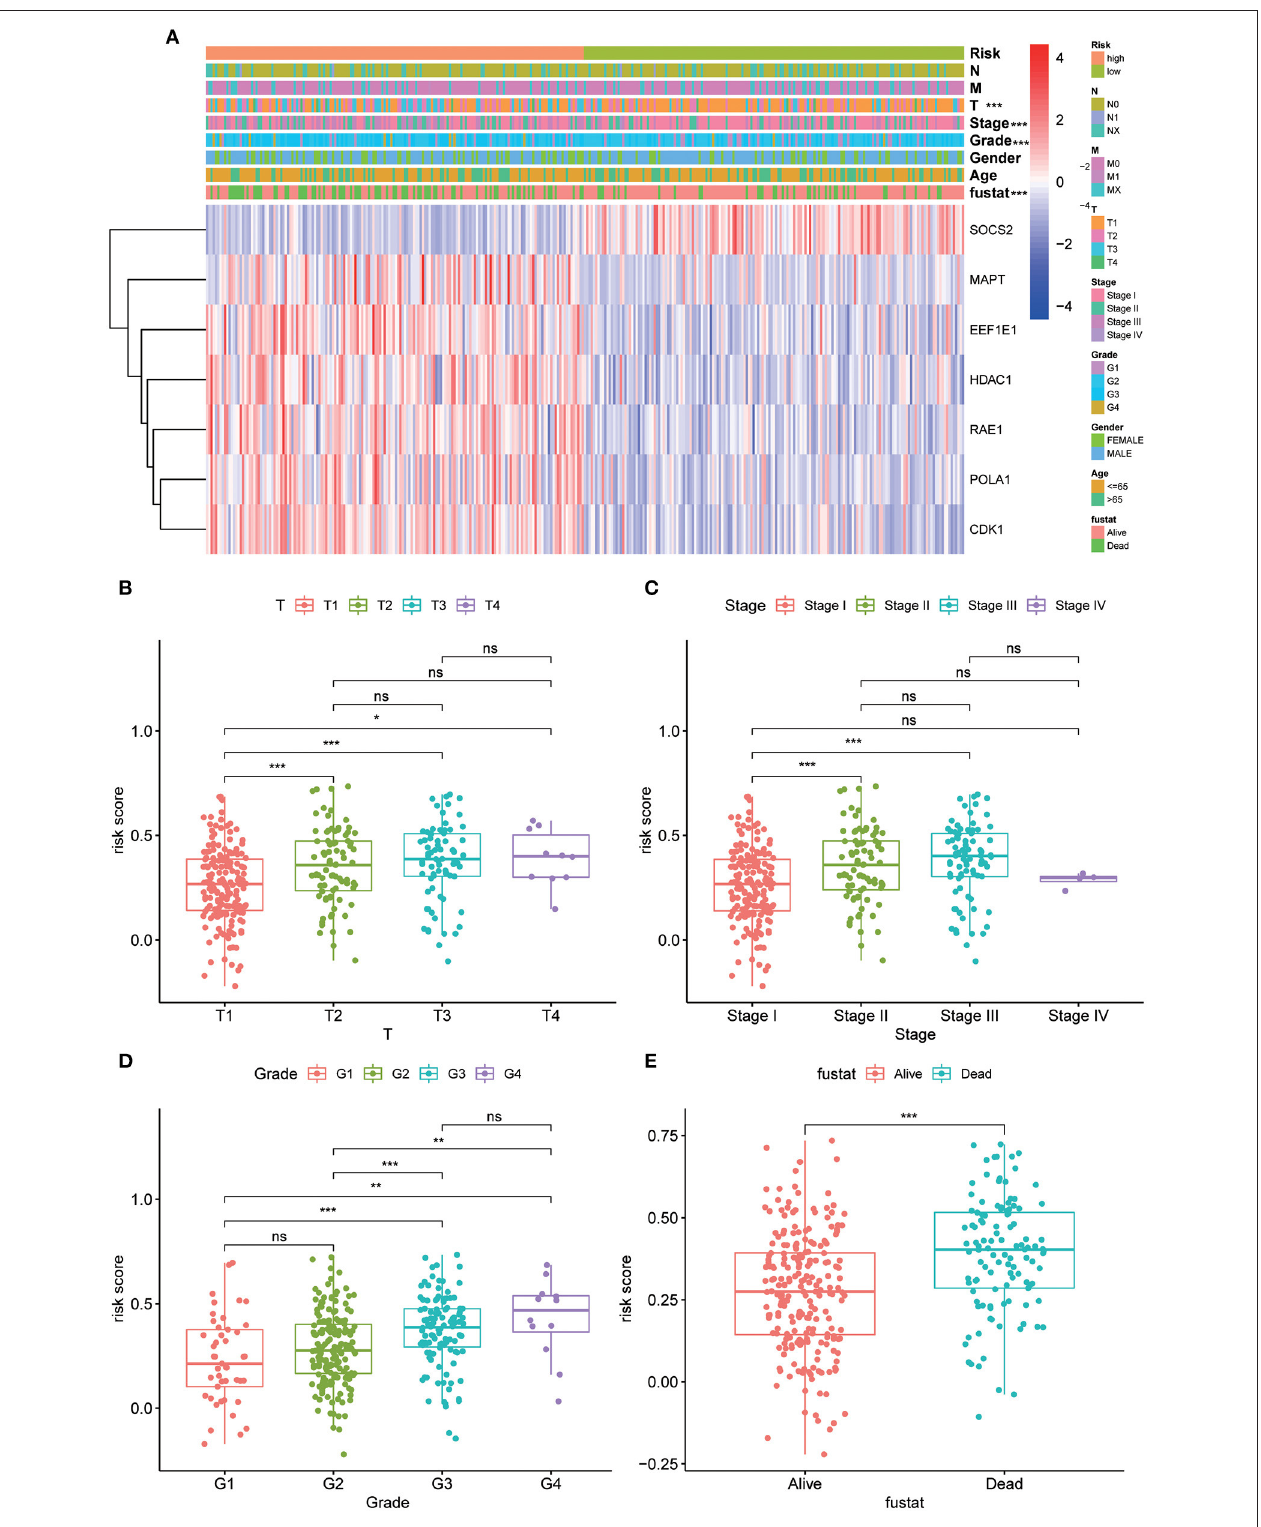
FIGURE 4 | Clinicopathological characteristics evaluation by the current 7 AGs model. Strip chart (A) along with the scatter diagram of (B) T stage, (C) clinical stage, (D) tumor grade, and (E) survival status between groups of high and low risk. Adjusted p values are shown as ns, not significant; * p < 0.05; ** p < 0.01; *** p < 0.001.